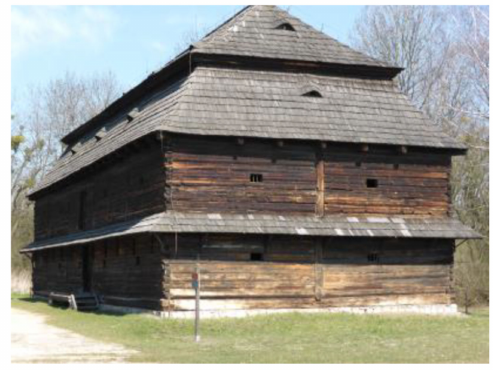
Figure 18. Old granary building.